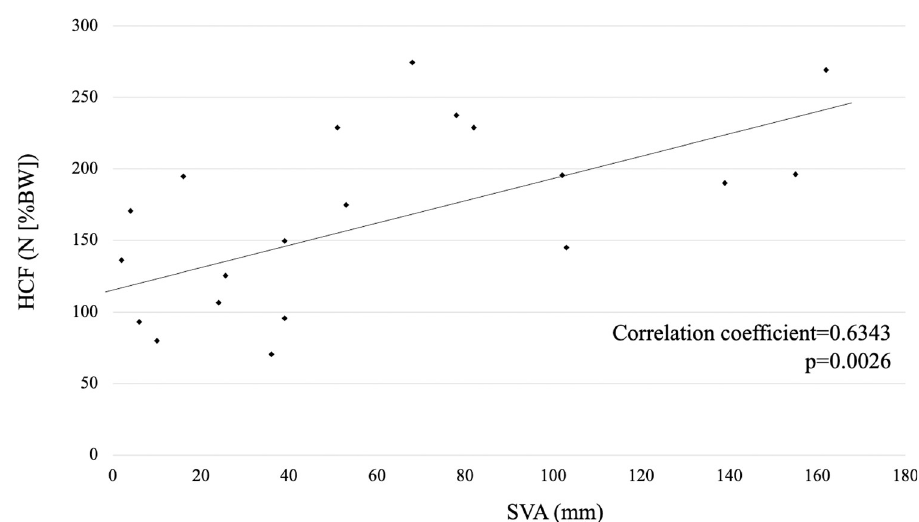
Fig 6. Correlation between the sagittal vertical axis (SVA) and hip contact force (HCF).